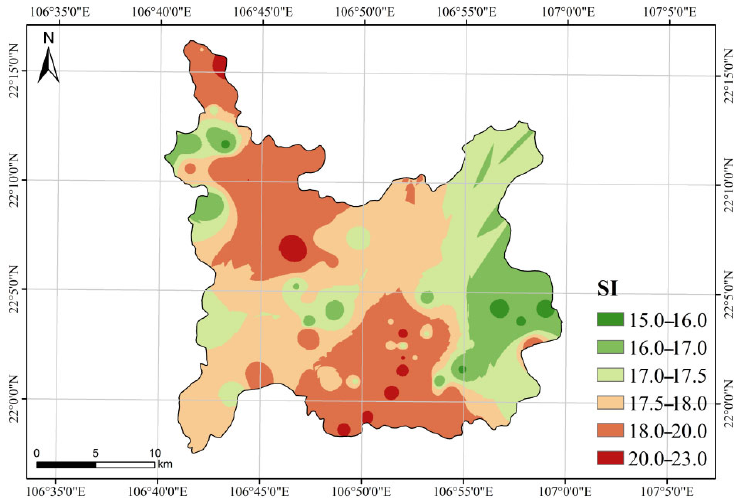
Figure 6. Map of the SI.